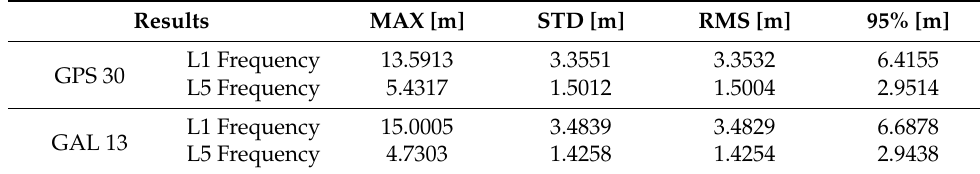
Table 4. Multipath error and noise results.